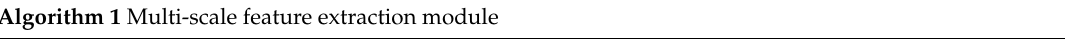
Algorithm 1 Multi-scale feature extraction module